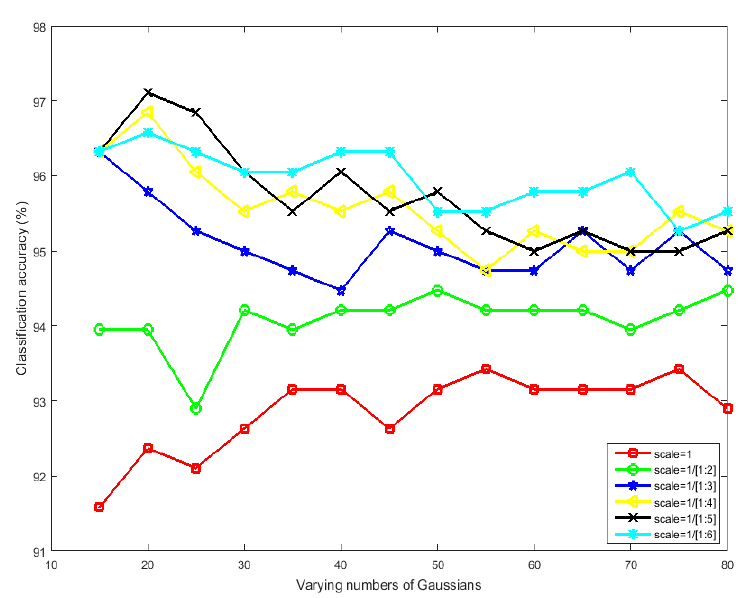
Figure 10. Classification accuracy (%) versus varying numbers of Gaussians and scales for our proposed method for the 19-class satellite scene dataset.